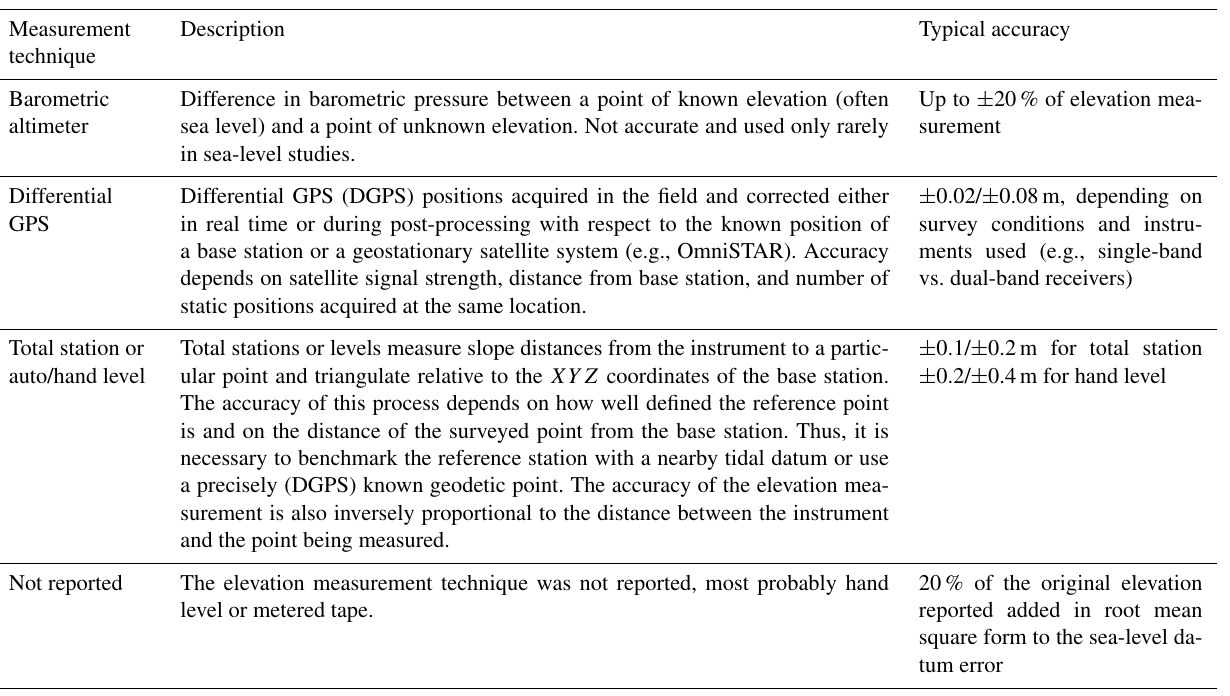
Table 2. Measurement techniques used to survey the elevation of last interglacial shorelines in the EAWIO region. Exported from Boyden et al. (2020).